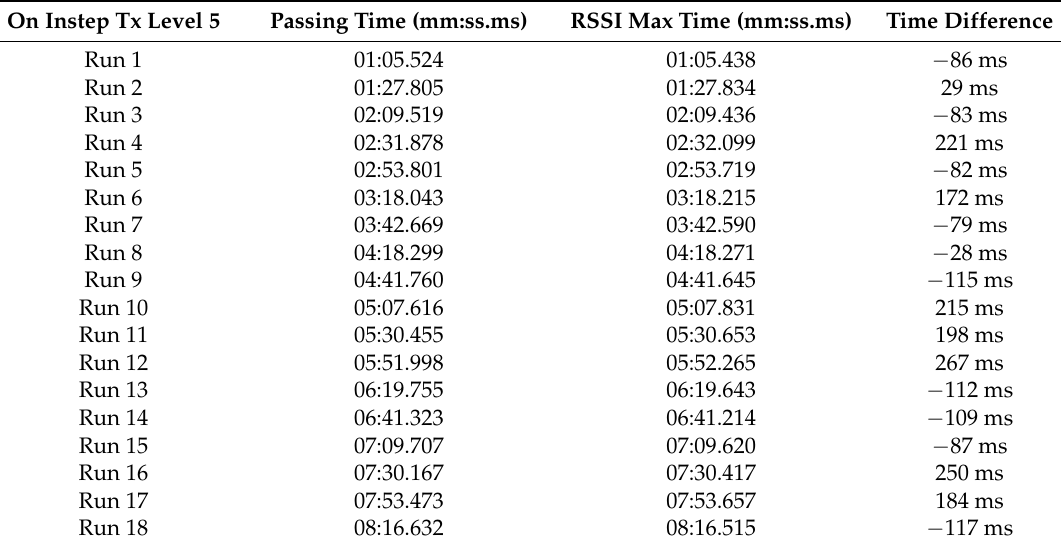
Table 9. The dynamic experiment when the Tx power of the BLE Tag on the instep is set at Level 5.